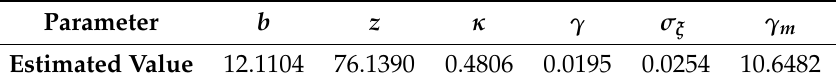
Figure 5. U.K. Nominal Rates (1970–2012). Table 4. Mortality